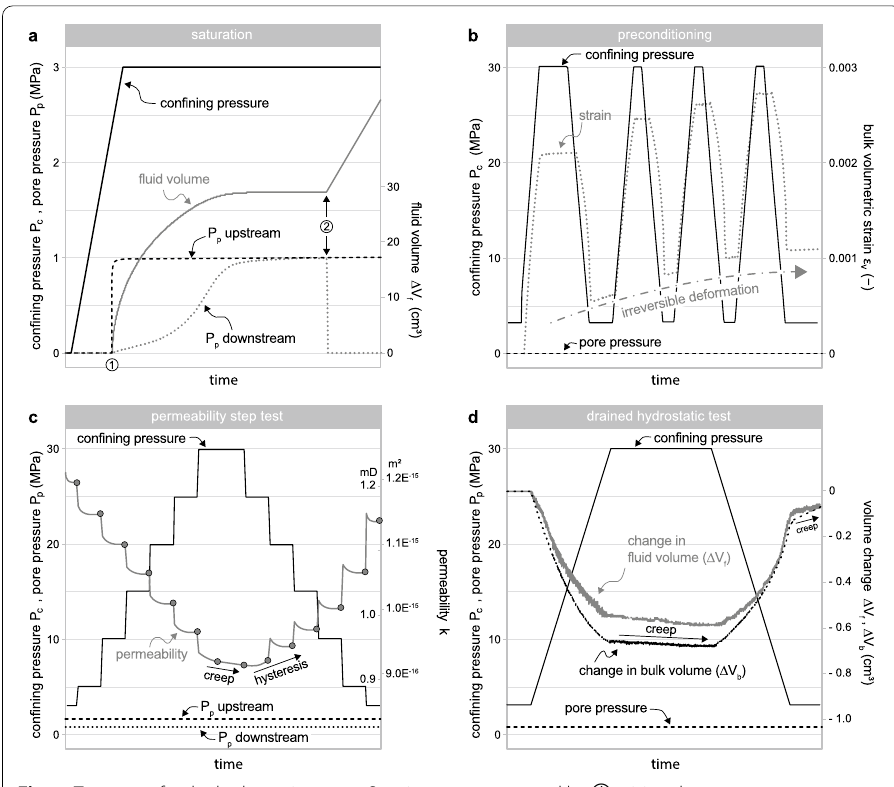
Fig. 1 Test setup for the hydrostatic tests. a Specimen was saturated by ① raising the upstream pore pressure to 1 MPa and waiting for pressure equalization, while the downstream flow port is closed. The specimen was flushed after opening the downstream fluid port ② to remove trapped air. b Cycling of confining pressure for reduction of inelastic effects and closure of microcracks. The strain shows irreversible deformation and relaxation hysteresis during unloading. c Permeability was determined after reaching stationarity for hydrostatic pressure steps of 5 MPa. Permeability shows a further decrease during the holding phase at maximum pressure due to creep and hysteresis at the beginning of the unloading cycle. Permeability cannot completely recover at the end of the unloading cycle as a result of irreversible sample deformation. d Change in fluid and bulk volume was measured during hydrostatic loading and unloading at drained conditions with fixed pore pressure and indicates a reduction in